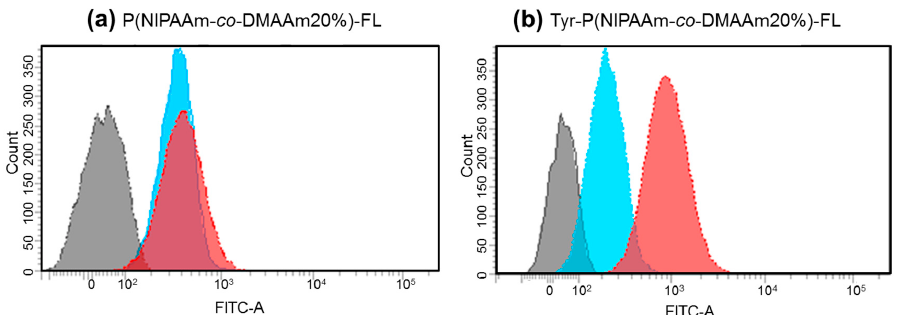
Figure 6. Representative flow cytometry histograms of fluorescence intensity of HeLa cells after 4 h incubation with ( a ) P(NIPAAm- co -DMAAm20%)-FL and ( b ) Tyr-P(NIPAAm- co -DMAAm20%)-FL at 34 °C (blue) and 40 °C (red).